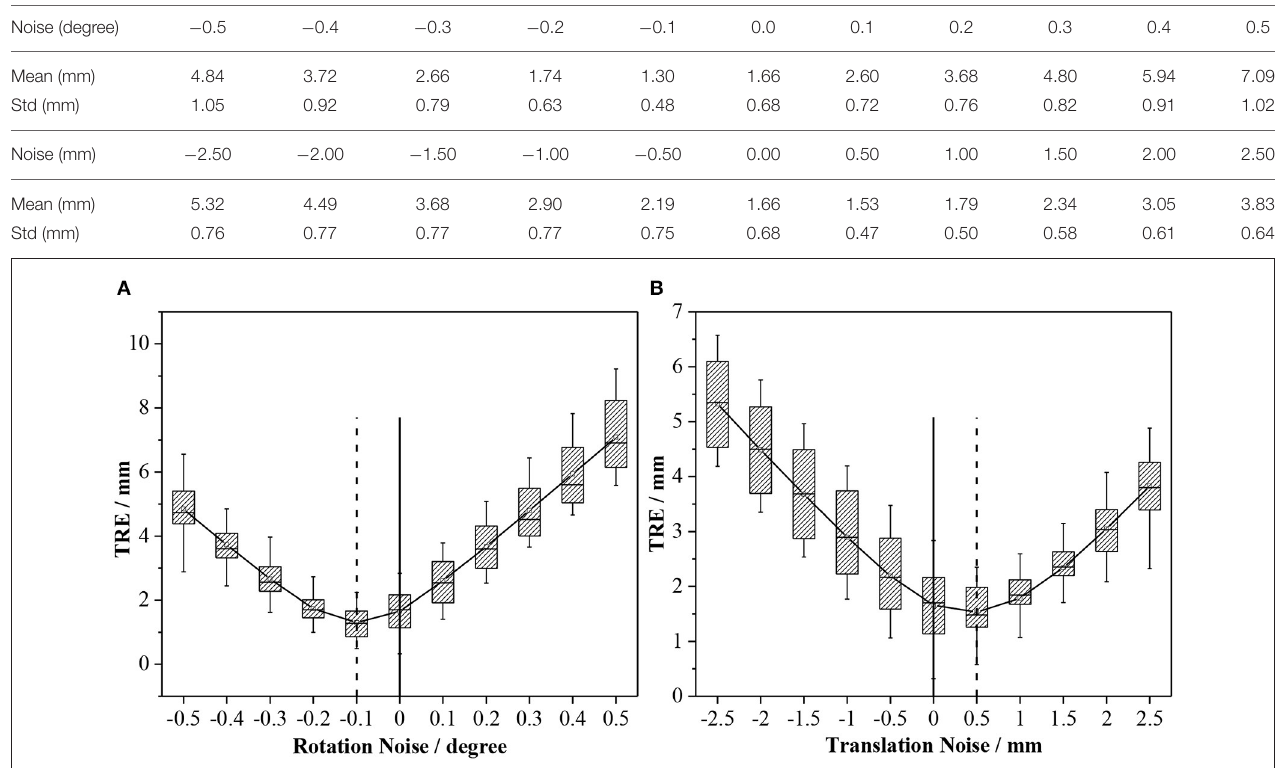
FIGURE 12 | Effects of different levels of noise on TRE: (A) Rotation noise; and (B) translation noise.